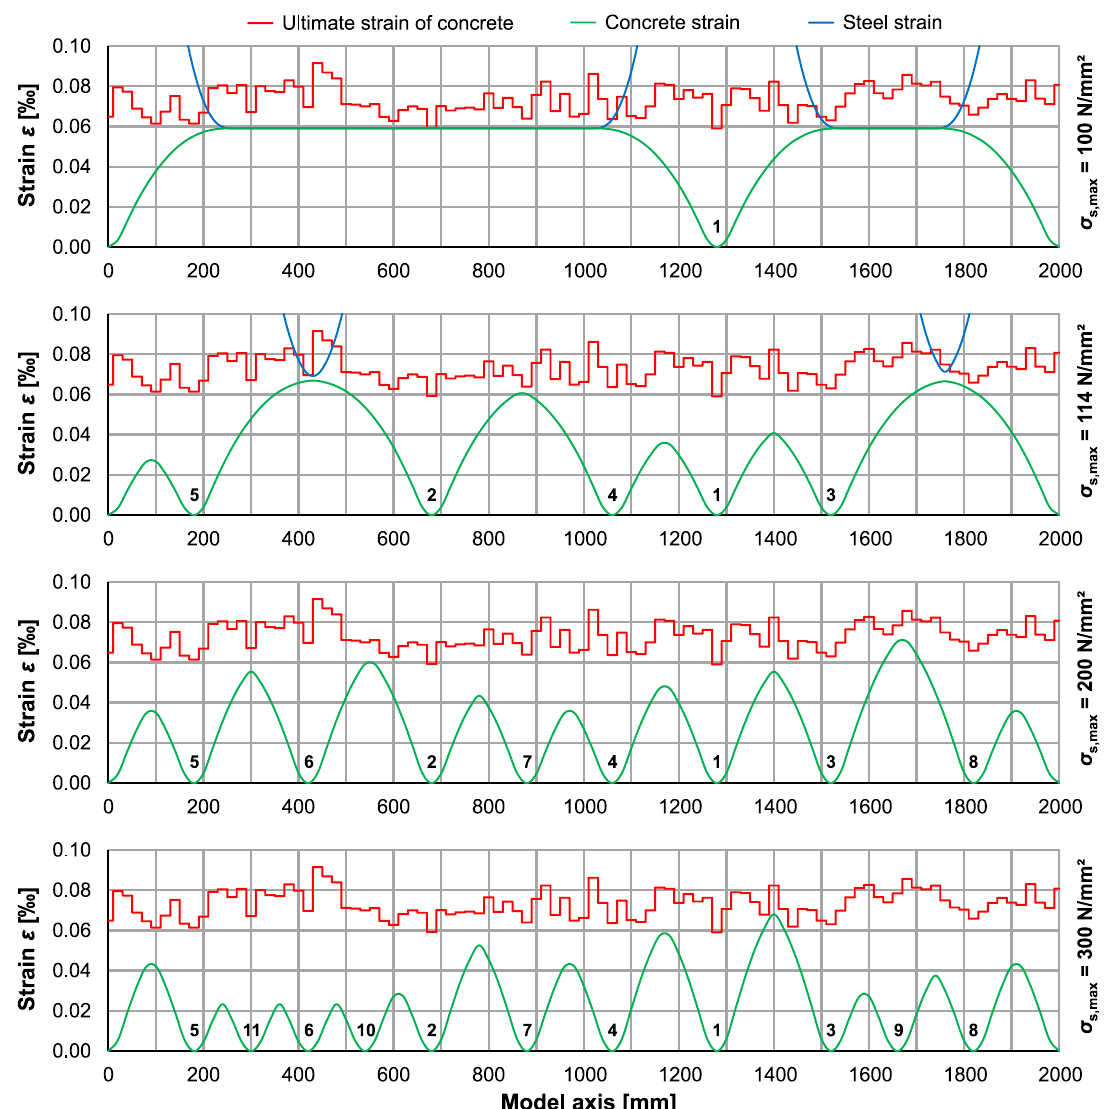
Figure 13. CPM case example showing the stress distributions and crack sequences along the model axis for different stress levels.